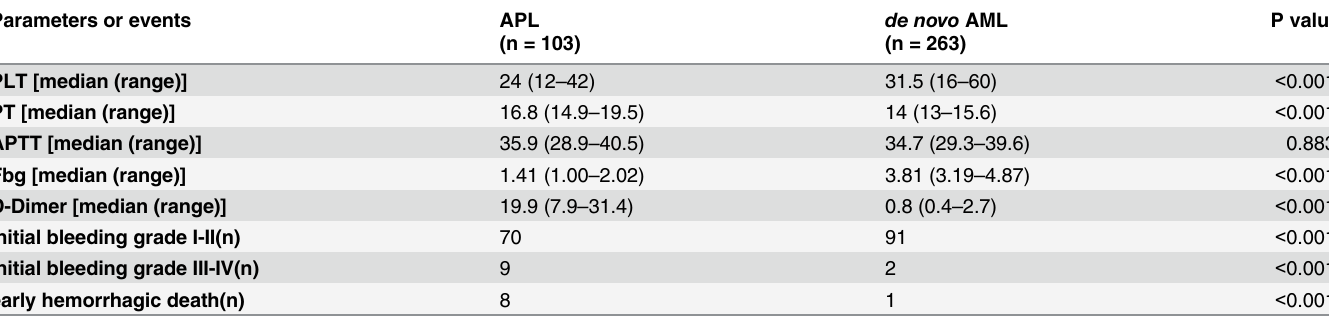
Table 1. Evaluation of hemostatic parameters and Incidence of bleeding events in patients with APL or de novo AML (other than APL).